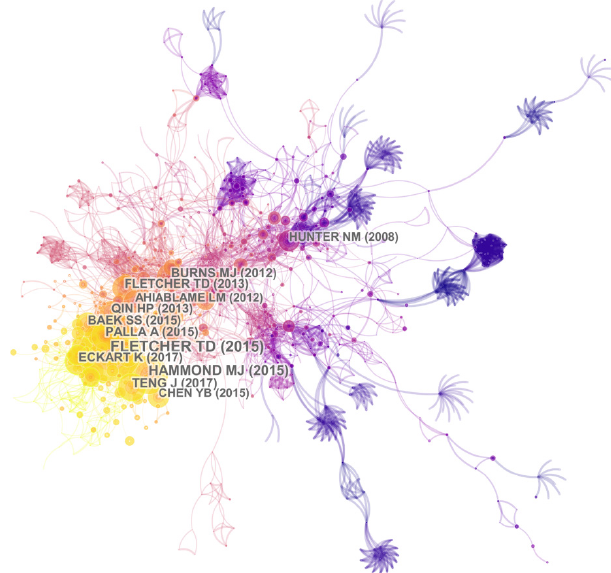
Figure 8. Co-citation network of references.